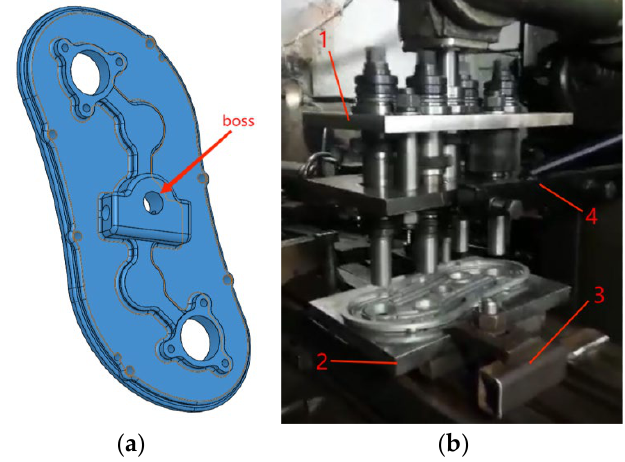
Figure 9. ( a ) Three dimensional diagram of the gearbox; ( b ) boring process processing. The following parts are shown: 1, processing tools; 2, positioning base; 3, special fixture, 4, tool support.